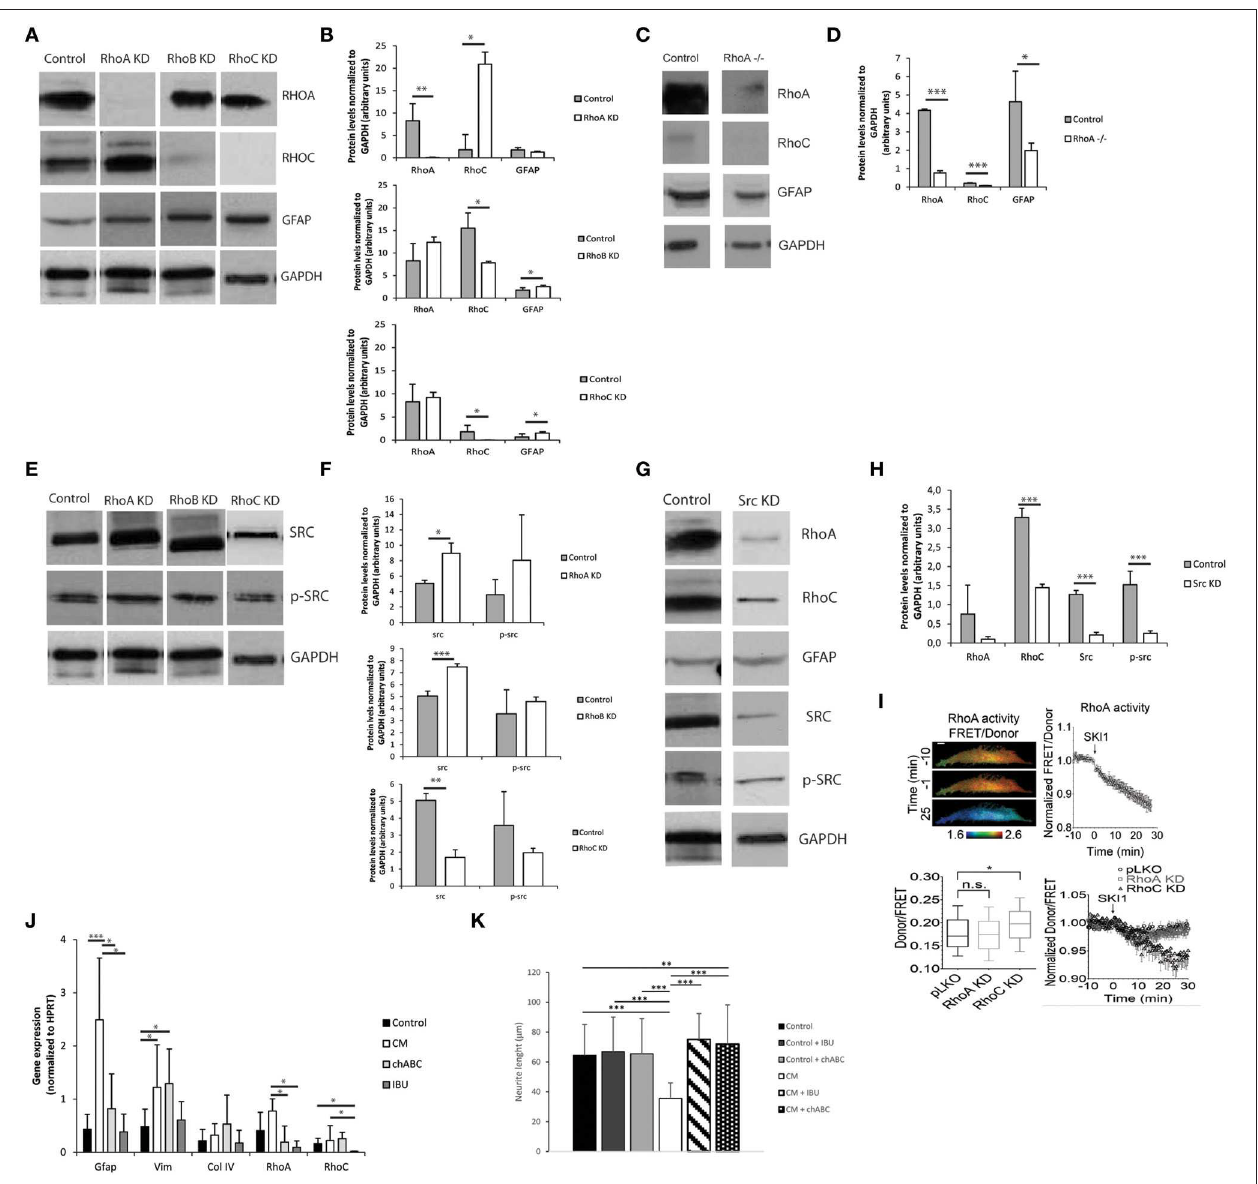
FIGURE 6 | The Rho-ROCK pathway influence on astrocyte reactivity. Results are shown as mean ± standard deviation; statistical analysis was performed between conditions at each time point, * p < 0.05 , ** p < 0.01 , *** p < 0.001 (A) Representative images of western blots of RHOA, RHOC, and GFAP levels on RhoA, RhoB, and RhoC knockdown astrocytes; (B) Western blot quantification ( n = 3 ); (C) Representative images of western blot of lox/lox RhoA -/-; (D) Western blot quantification ( n = 3 ); (E) Representative images of western blot of c-SRC levels on RhoA, RhoB, and RhoC knockdown astrocytes; (F) Western blot quantification ( n = 3 ); (G) Representative images of western blot from Src Knockdown astrocytes; (H) Western blot quantification ( n = 3 ); (I) FRET analysis of RHOA and SRC activity in astrocytes. SKI-1 was used as a chemical inhibitor of SRC; (J) Effect of the treatment of reactive astrocytes with 0.1 U/ml chABC and 0,04M ibuprofen. Astrocytes were cultured for 7 days in the presence of CM and then treated with chABC or Ibuprofen for 48h. (KD stands for knockdown); (K) Effect of reactive astrocytes treated with chABC or ibuprofen (IBU) on cortical neurons. Neurons were cultured in glass coverslips and alginate discs with astrocytes were placed on top using transwells.